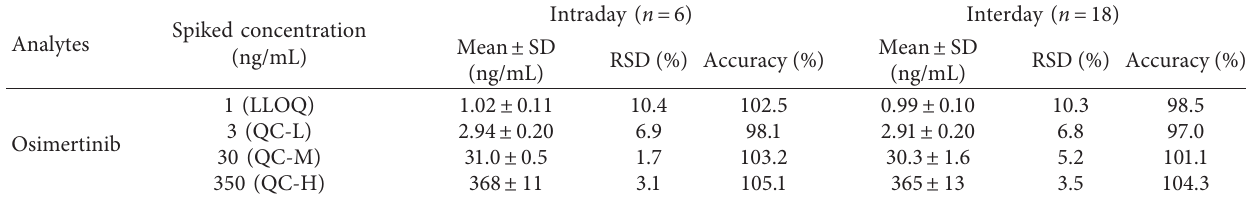
Table 3: Intraday and interday precision and accuracy of osimertinib in rat plasma.